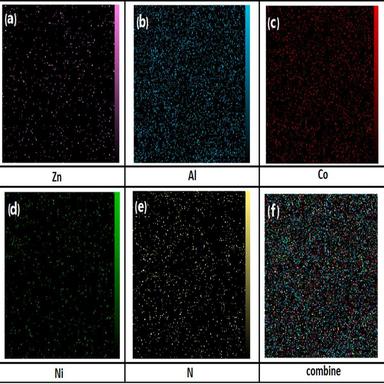
EDX mapping of ZIF/Ni(17%)Co(50%)Al(33%)-LDH.